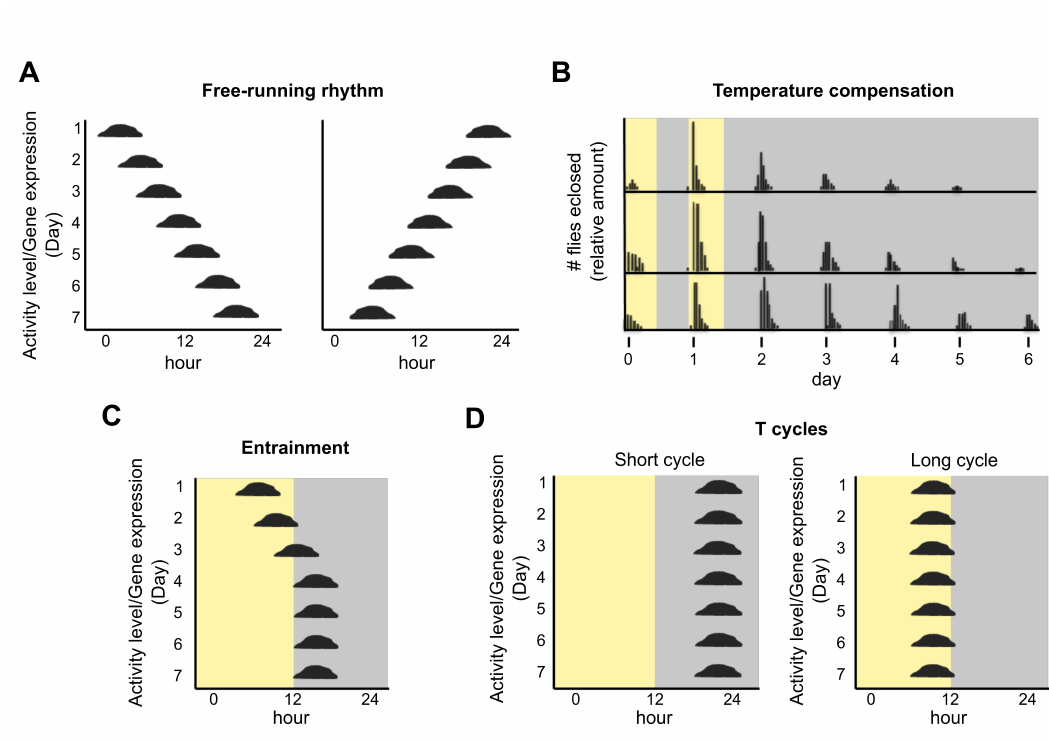
Figure 1. Characteristics of circadian clocks (see also [6]). ( A ) A free-running rhythm in constant conditions can have a period that is either slightly longer (left panel) or slightly shorter (right panel) than 24 h. Graphing the activity / amount (y-axis) over the course of the day (x-axis), such that changes from day to day are visually obvious (seen from top to bottom), facilitates an implicit understanding of period and phase of the circadian rhythm. ( B ) The eclosion of Drosophila occurs once per ca . 24 h in constant conditions following 2 days of entrainment in a 24 h light dark cycle (depicted as yellow and grey). The top of the panel shows eclosion at 26 ◦ C, the middle shows 21 ◦ C, and the bottom shows 16 ◦ C. The timing of eclosion (and hence its period or frequency) remains almost the same over this broad range of physiological temperatures, and hence it is temperature compensated. Data are redrawn from Pittendrigh [7]. ( C ) The circadian rhythm entrains (synchronizes) to exactly 24 h in a zeitgeber cycle, shown here as a light-dark cycle. The rhythm gradually (days 1–4) finds a stable time of day (phase) relative to the zeitgeber (days 4–7). ( D ) T cycles are an experimental paradigm used to elucidate a biological clock. It places a rhythmic organism into entraining cycles of di ff erent lengths. The stable phase depends on the relationship between the period of the biological rhythm and the zeitgeber cycle. Most circadian rhythms entrain to a later phase in a shorter cycle and earlier phase in a longer one. Changes in phase angles in di ff erent T cycles are a hallmark of circadian clocks and occur regardless of the period length of the rhythm. These changes in phase angle distinguish circadian time—keeping from masking e ff ects of the entrainment